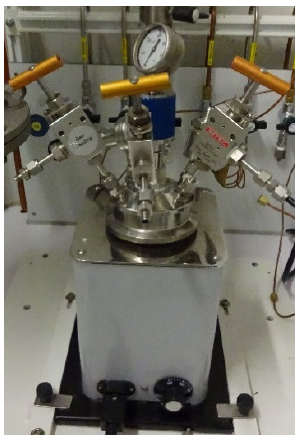
Figure 3. Hastelloy C4 autoclave used to carry out the COOL-Process.